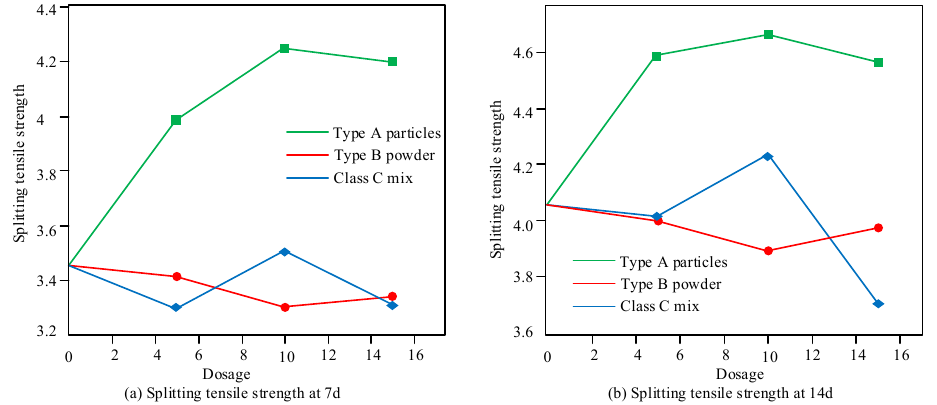
Figure 3. Splitting tensile strength of ER concrete. Table 4. Mass loss rate and strength loss rate of ER